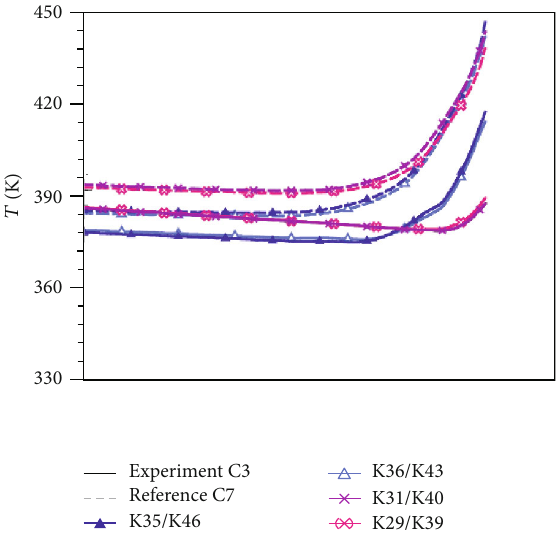
Figure 24: More temperatures on AKTiV and the reference set-up. Solid curves indicate thermocouple signals K29-K38 of the cooled experiment AKTiV while dashed curves represent signals K39-K46 of the uncooled reference with an identical set-up [42].